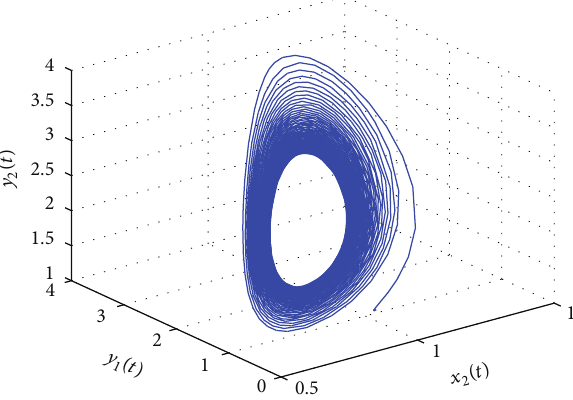
Figure 5: The phase plot of the states 𝑥 1 , 𝑥 2 , 𝑦 2 for 𝜏 1 = 4.71500 > = 4.5061 . 𝜏 10